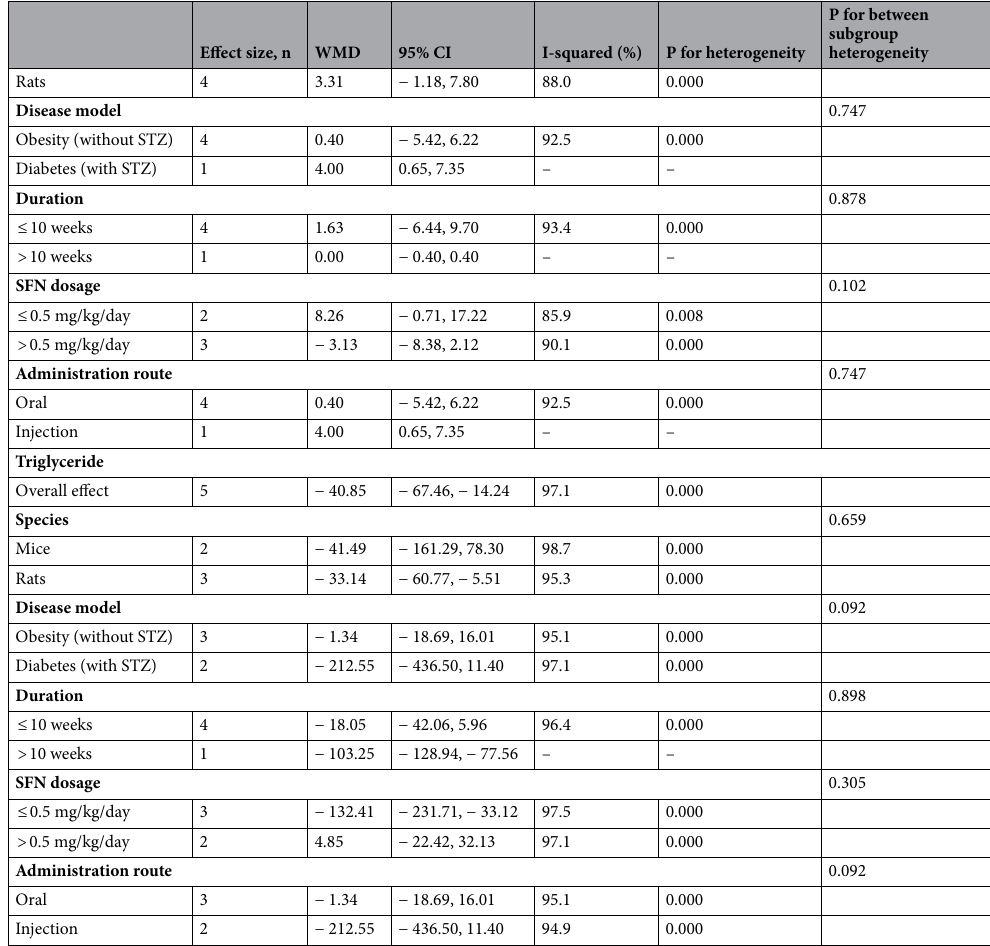
Table 2. Subgroup analysis to assess the effect of SFN supplement on lipid profile.